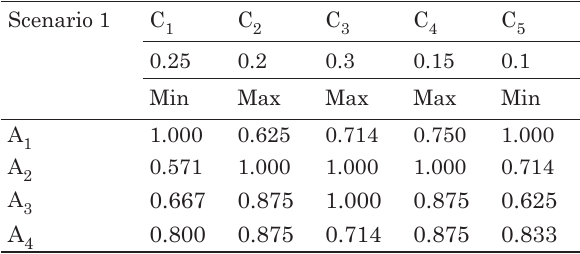
Table 4. normalized decision-making matrix for